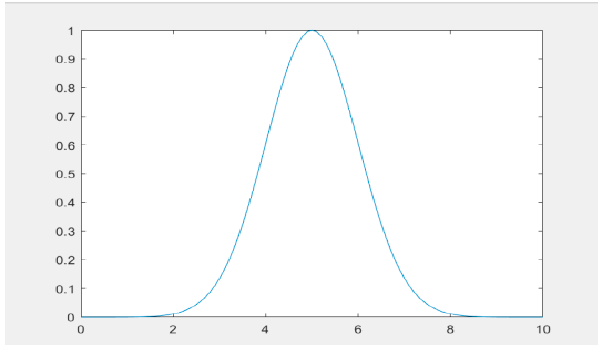
Figure 14. Gaussian radial basis function.